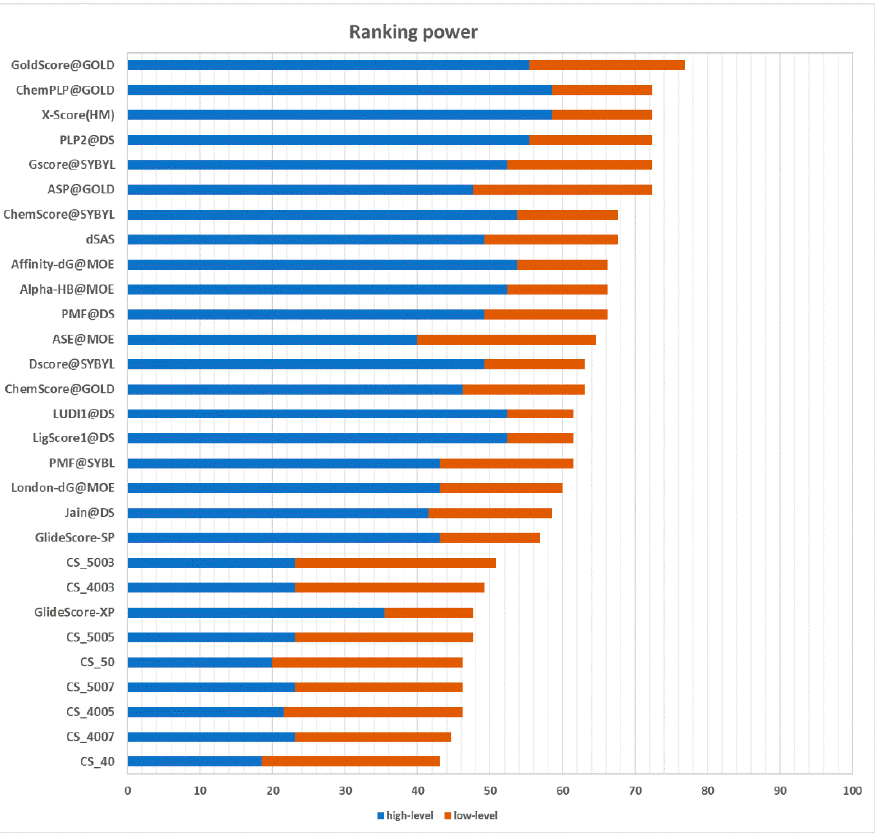
Figure 6. Success rates of scoring functions in the ranking power test for high-level prediction (blue bars) and low-level prediction (orange bars).